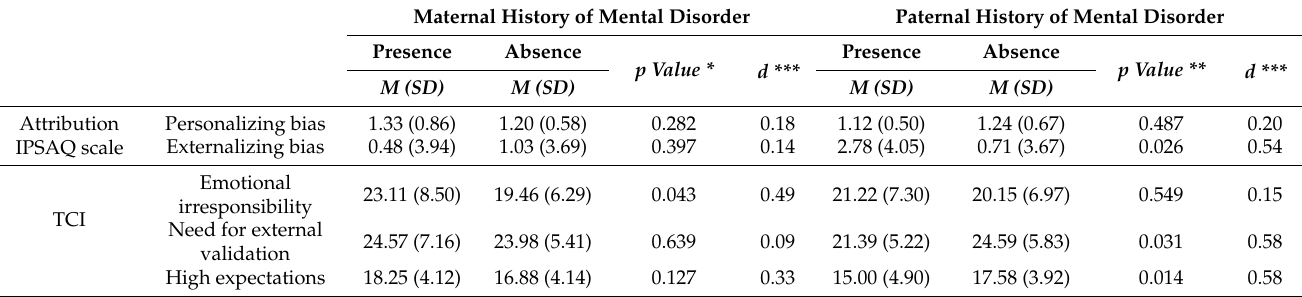
Table 4. Relationship between maternal and paternal history of mental disorder and metacognition and social